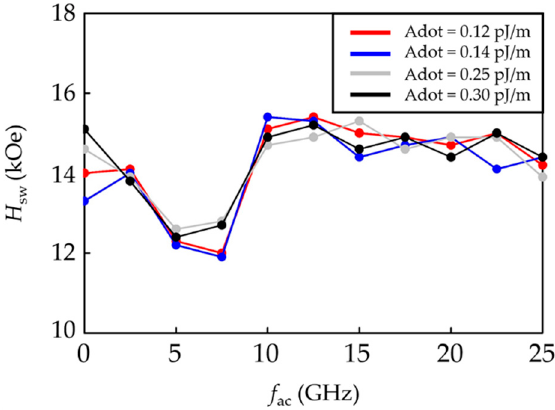
Figure 2. H sw of the bilayer ECC-BPM versus f ac at various A dot .